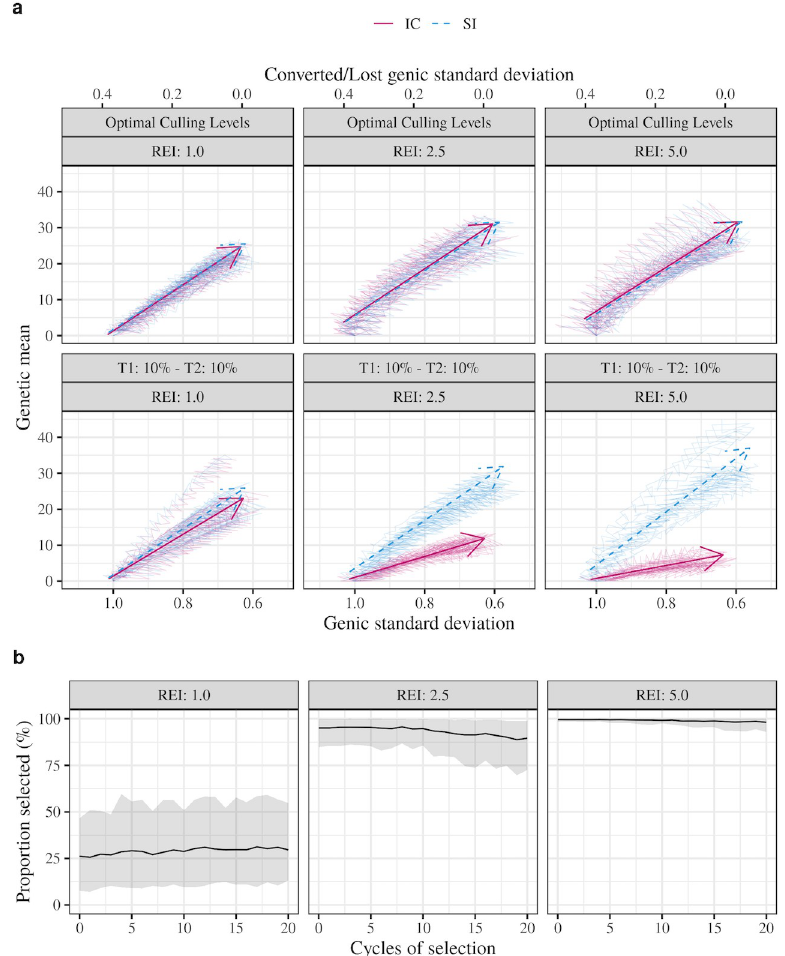
Fig 4. Change of genetic mean and genic standard deviation for the index trait across 20 cycles of selection using either independent culling (IC) or a selection index (SI) under three levels of relative economic importance (REI) and using either the same proportion selected (10%) for Trait 1 (T1) and Trait 2 (T2) or optimal culling levels for each level of relative economic importance of T2 (a); and proportion selected (mean and 95% confidence interval) for T1 used to achieve optimal culling levels over the 20 cycles of selection (b). Traits are unfavourably correlated (-0.5). Individual replicates are shown by thin lines and a mean regression with a time-trend arrow. Values of genetic mean and genic standard deviation shown are standardized to mean zero and unit standard deviation in cycle